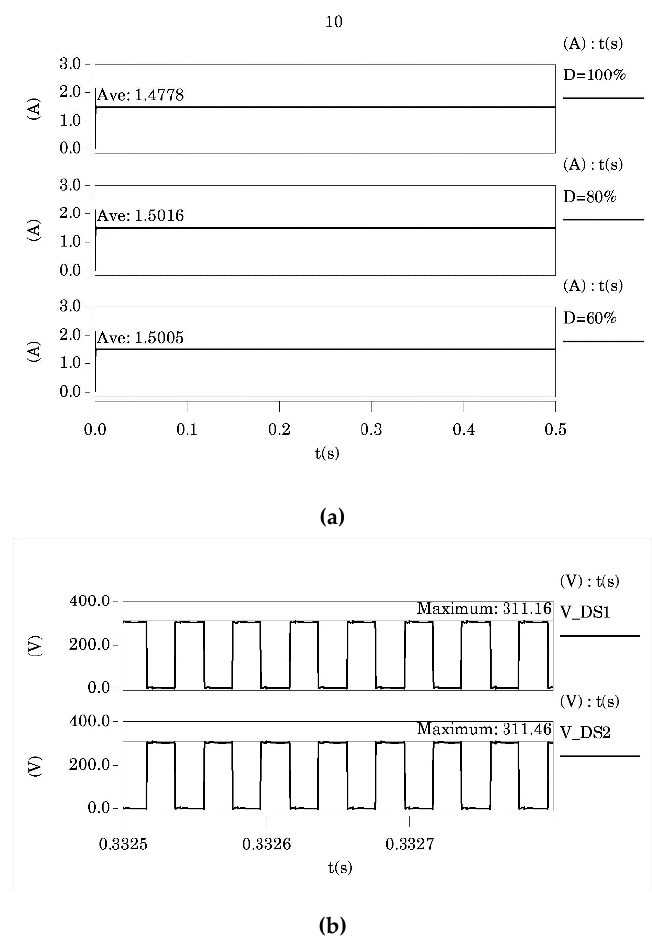
Figure 10. Schematic diagram of simulation results of constant current isolation circuit: ( a ) Schematic diagram of current simulation between nodes A and B (the duty cycle of switching tubes S 1 and S 2 are 60%, 80% and 100%); ( b ) schematic diagram of simulation results for voltages of Drain to Source (DS) poles of switching tubes (the duty cycle is 100%).